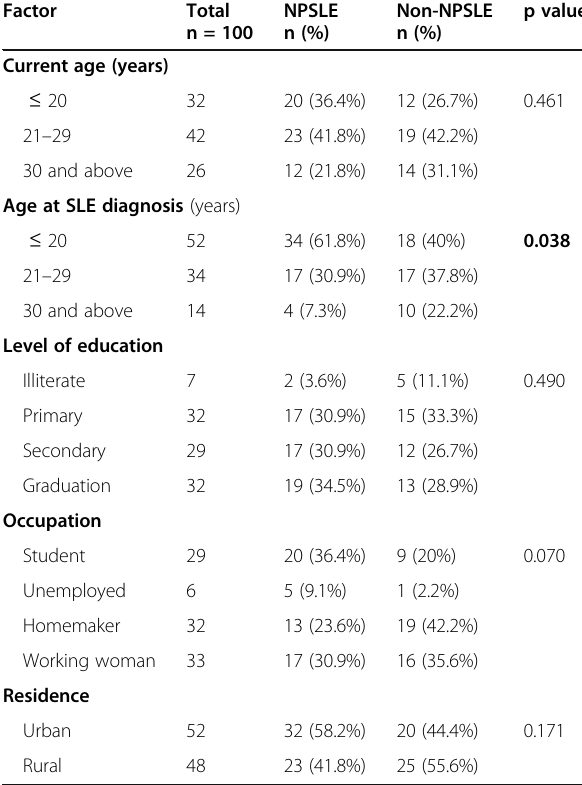
Table 3 Sociodemographic factors of respondents and their association with